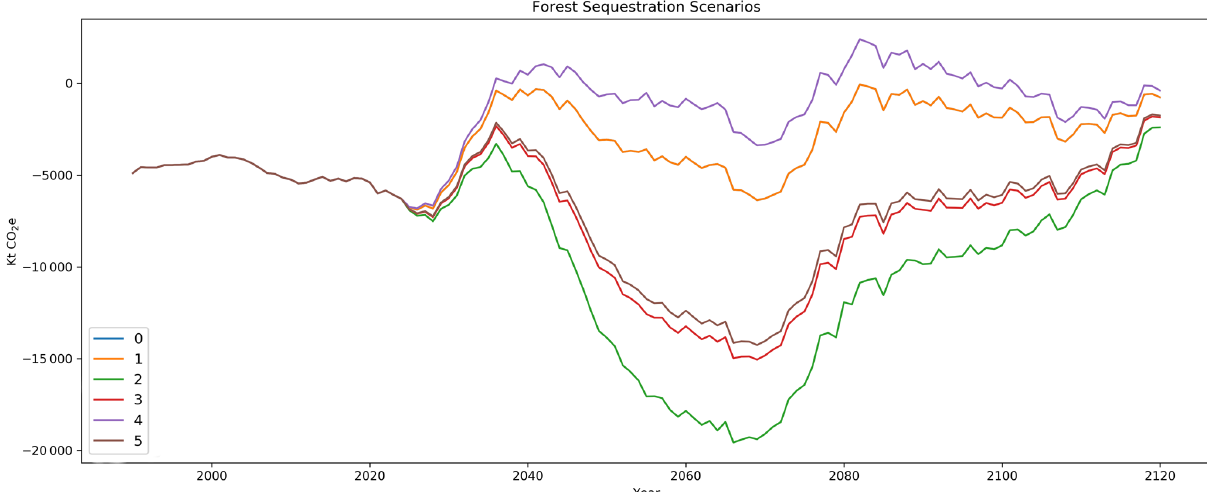
Figure 13. Net marginal GHG flux (accounted for as CO 2 e balance) from forestry between 1990 and 2120 with zero afforestation after 2050 and 0% harvest